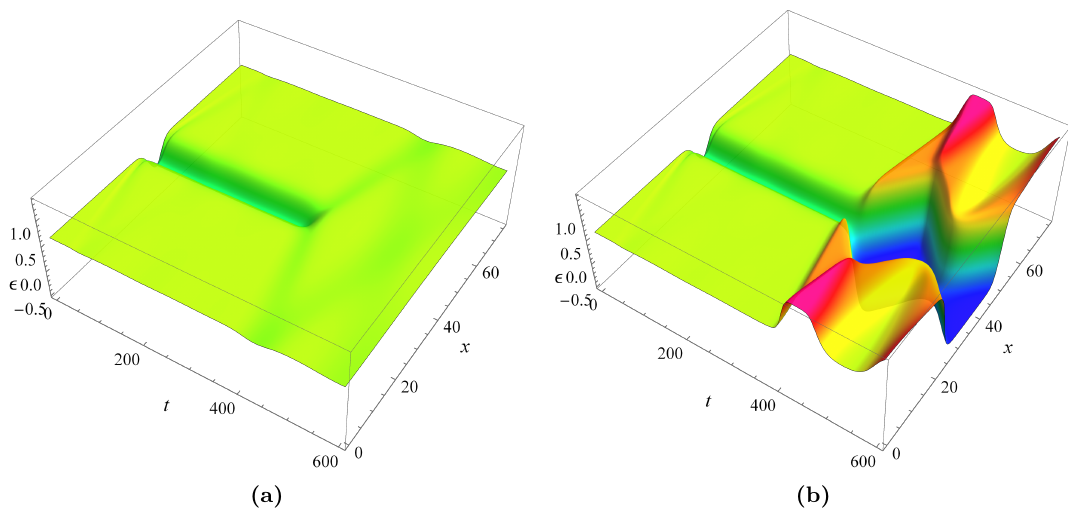
Figure 5. The energy density as a function of time with the parameter p is closest to the threshold p ∗ in the cases (a): p < p ∗ and (b): p > p ∗